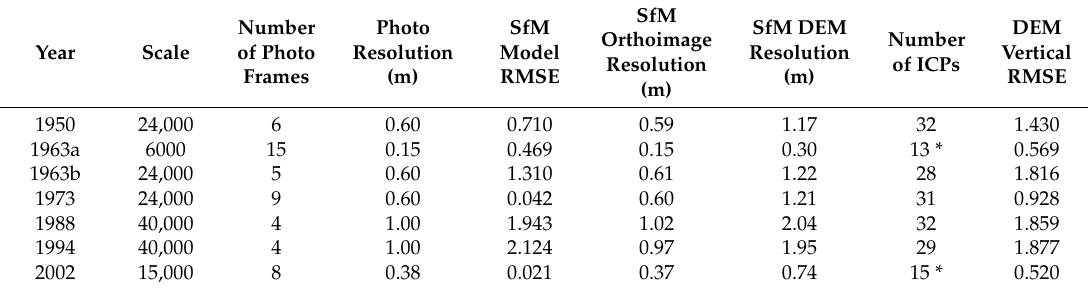
Table 4. Summary of SfM results for each set of historical aerial imagery.